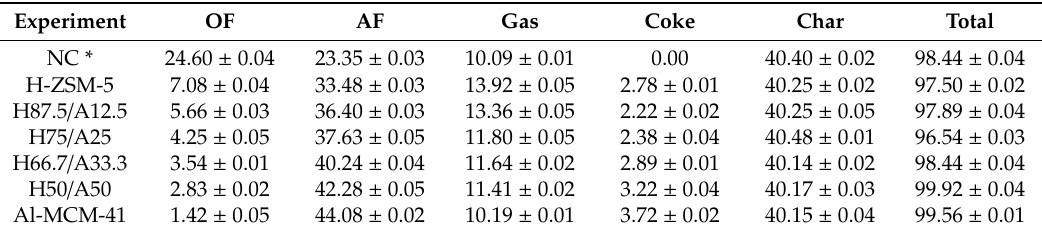
Table 1. Yields of Organic Fraction (OF) in liquid, Aqueous Fraction (AF) in liquid, non-condensable gases, and coke on catalysts in wt.% for the non-catalytic and catalytic pyrolysis with di ff erent proportions of H-ZSM-5 and Al-MCM-41.